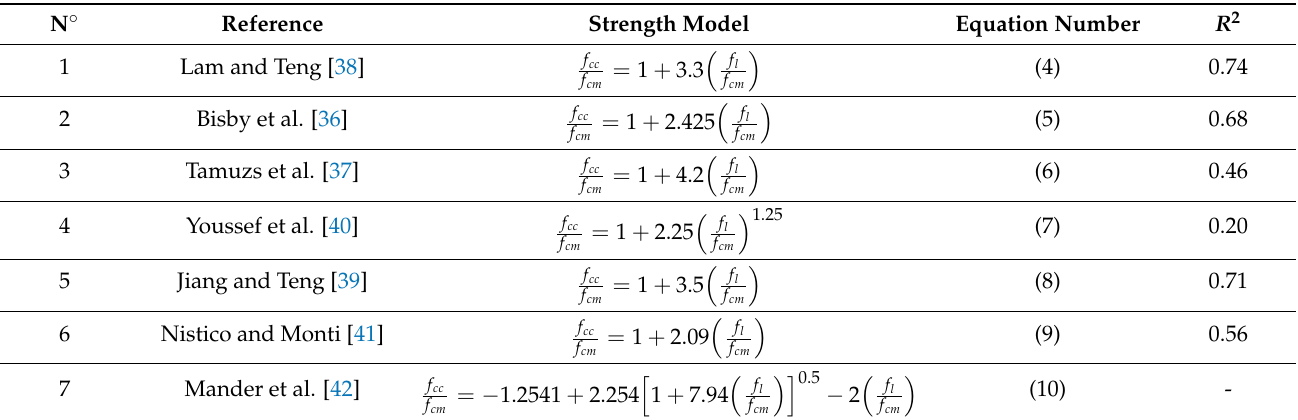
Figure 11. Effect of confinement ratio on ( a ) strength gain ratio, ( b ) strain gain ratio. The obtained results in terms of R² show that the model of Lam and Teng [38] (Equation (4)) is the most suitable for the prediction of the stress gain, while the model of Jiang and Teng [39] (Equation (11)) is the most suitable for the strain gain prediction. The experimental versus predicted results are depicted in Figure 12. Table 4. Ultimate strength models.